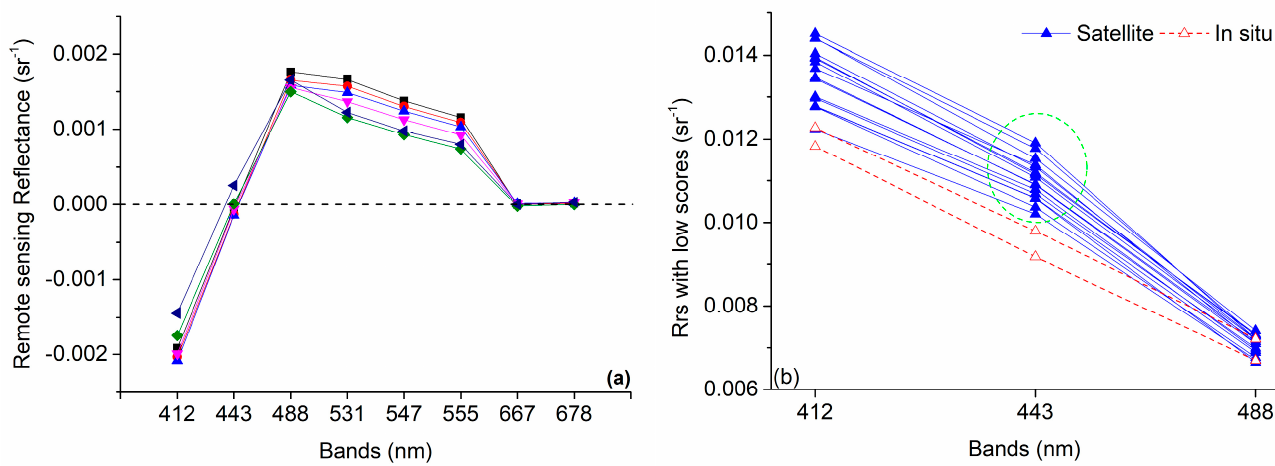
Figure 6. Samples of low quality R rs ( λ ) spectra derived from MODIS–Aqua, in the BB (scores < 0.3) characterized by negative values at 412 nm and 443 nm bands ( a ), and in the OZ (scores < 0.7) compared with in situ measured R rs ( λ ) spectra ( b ).